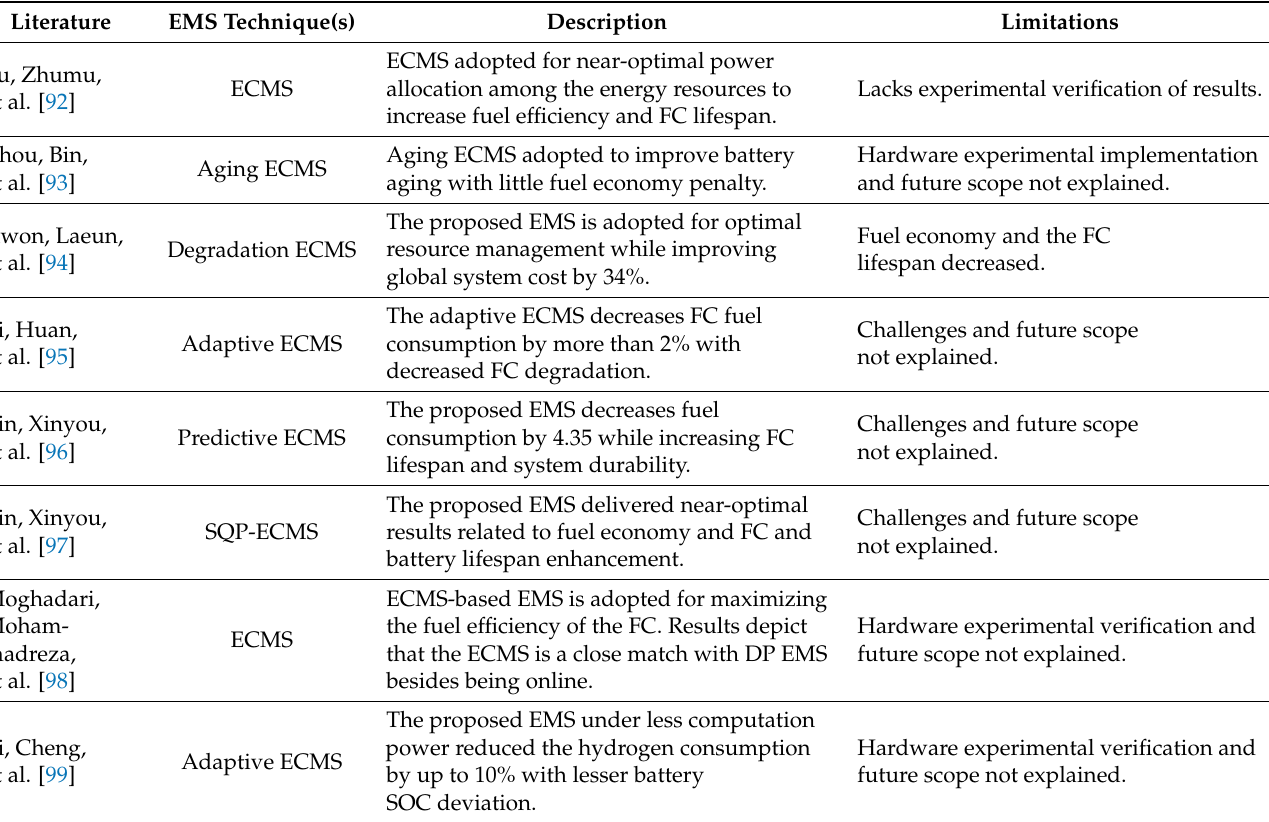
Table 9. Summary of the latest literature related to ECMS and adaptive ECMS